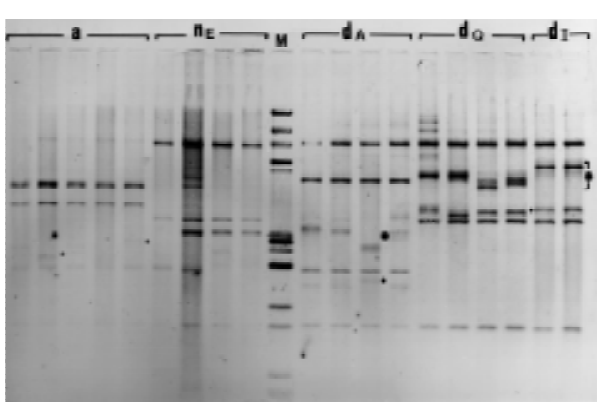
Figure 3 - mtDNA fragment patterns of Tropidurus amathites (a), T. nanuzae from Extração (n ), T. divaricatus from Alagoado (d E Ibiraba (d ) of Dra I. l DNA ( Hin dIII) and pBR 328 ( Bam HI, Bgl I and Hin fI) I were used as molecular size standards (M). (*) Molecular size variation and heteroplasmy.